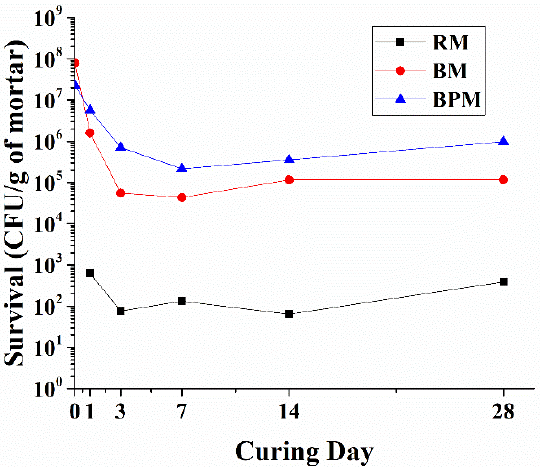
Figure 8. Survival rate of the bacteria calculated from CFU to the 1 g of ground mortar specimens from day 0 to day 28. The values of day 0 for RM, BM and BPM are calculated on the value diluted in the mortar based on the bacteria density measured just before mortar incorporation.